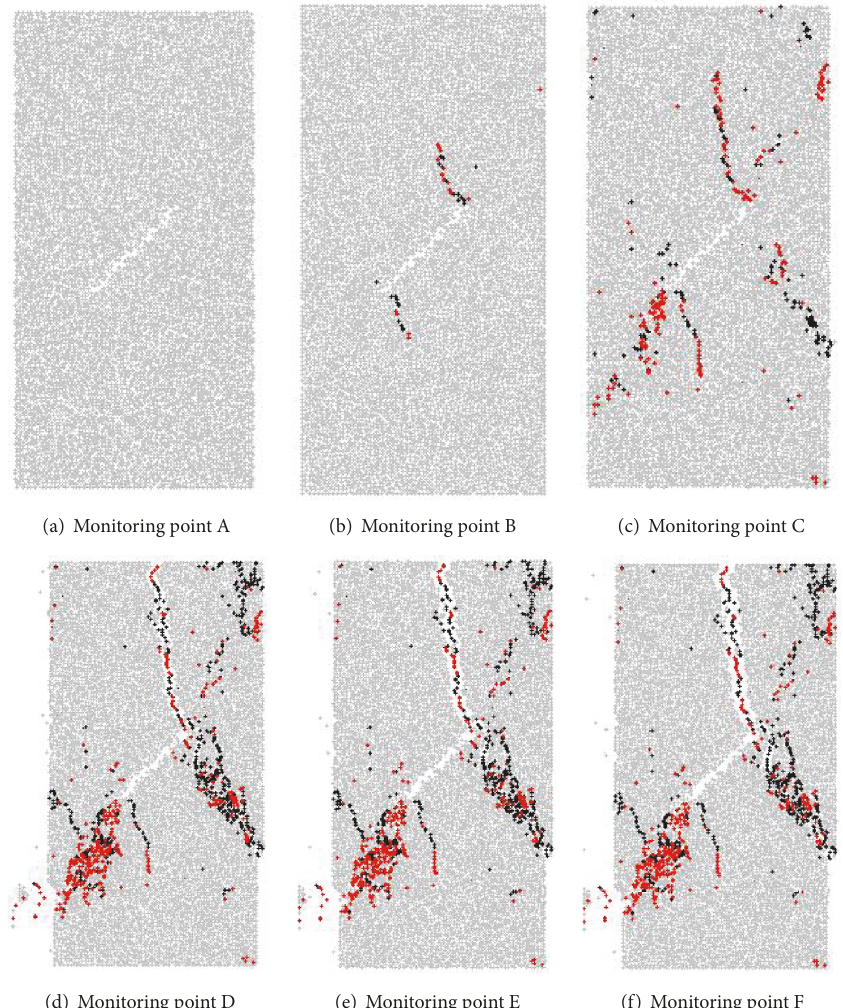
Figure 15: Evolution of microscopic cracks in a